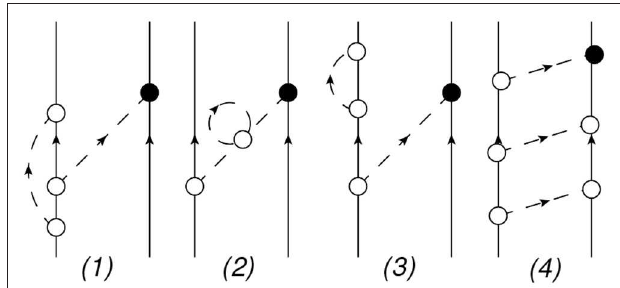
FIGURE 2 | Other diagrams that would contribute at NLO. These diagrams contribute to the renormalization of the LECs (1–3) or give a vanishing contribution to the potential (4) due to the inversion of Equation (53). Notation as in Figure 1 .